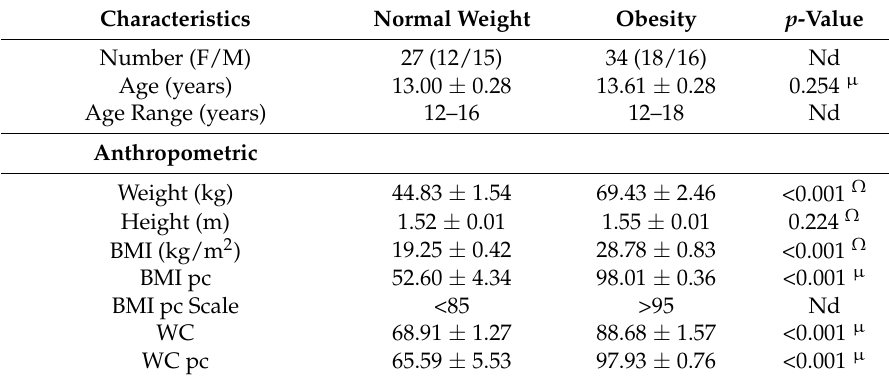
Table 2. Clinical characteristics of 12–18-year-old